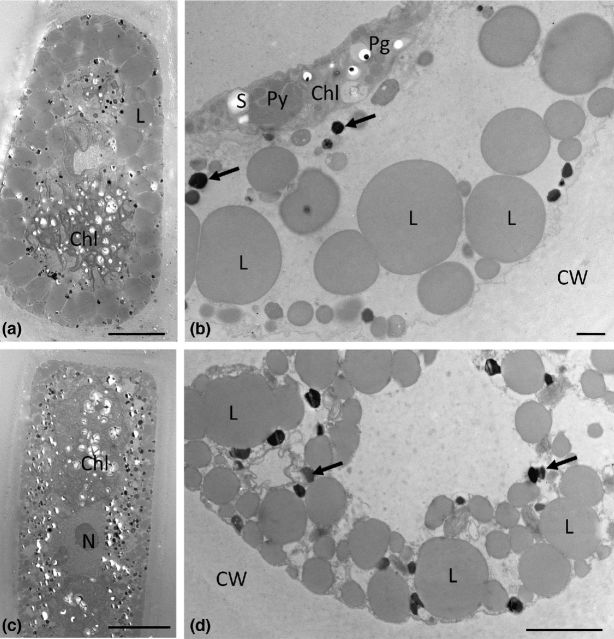
Transmission electron micrographs of mature vegetative cells of Zygnema sp. strains B (a, b) and C (c, d). (a) Overview showing the cell periphery filled with lipid bodies, and central chloroplasts; (b) detail of the cell periphery with cell wall, lipid bodies and electron-dense particles (arrows); the chloroplast contains starch grains and numerous plastoglobules: (c) overview with central nucleus and chloroplasts; lipid bodies and electron-dense particles in the cell periphery: (d) lipid bodies and electron-dense particles (arrows). Abbreviations: Chl chloroplast, CW cell wall, N nucleus, Pg plastoglobule, Py pyrenoid, S starch. Bars: a, c 10 μm; b, d 1 μm.